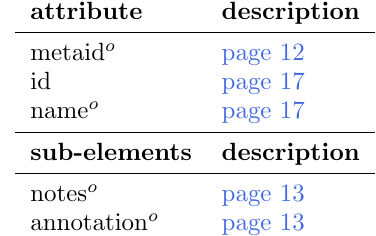
Table 2.18: Attributes and nested elements for abstractTask. o denotes optional elements and at- tributes.